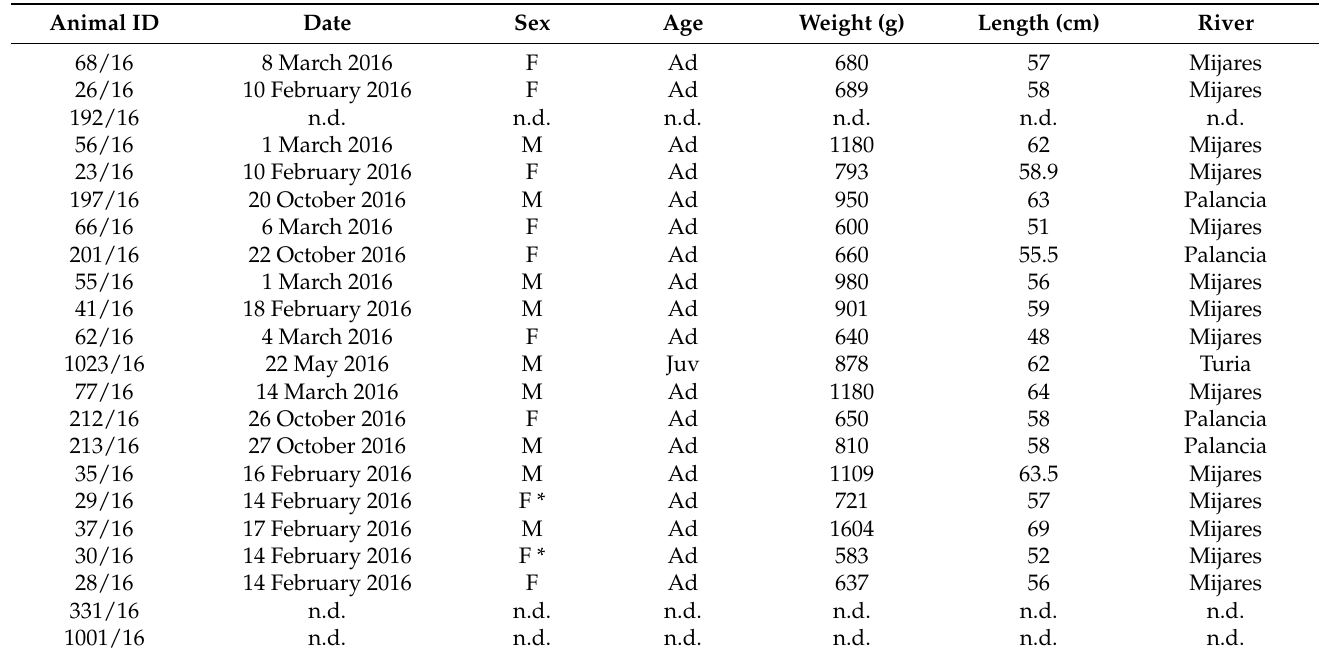
Table 2. Data from the animals captured.